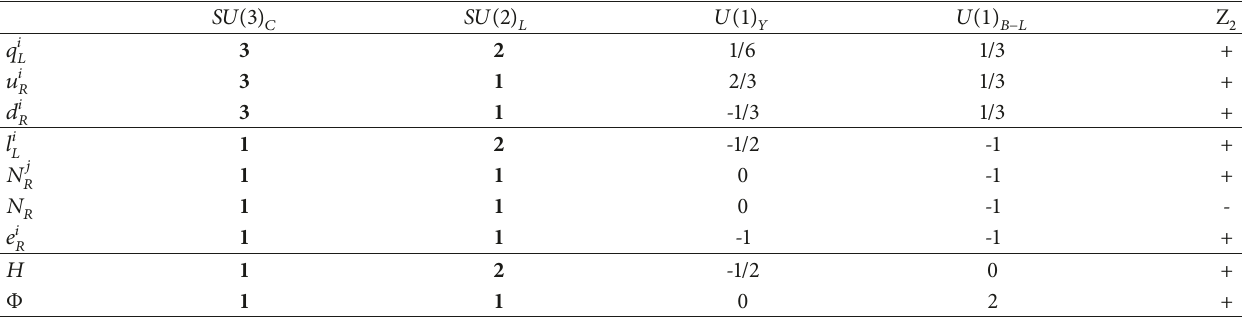
Table 2: The particle content of the minimal 𝐵 − 𝐿 extended SM with Z 2 symmetry. In addition to the SM particle content ( 𝑖 = 1 , 2 , 3 ), the 푗 𝑗 = 1 , 2 ) and 𝑁 𝐵−𝐿 Higgs field ( Φ ) are introduced. Because of the Z three right-handed neutrinos [ 𝑁 푅 ] and the 푅 ( here, 𝑁 푅 is a unique (cold) dark matter